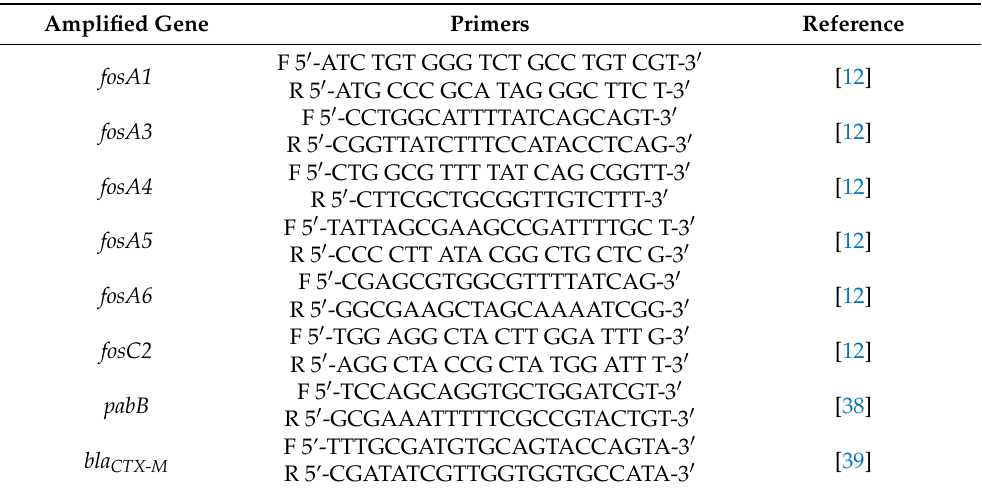
Table 3. Primers and PCR conditions used to determine the presence of fos and bla CTX-M genes and the O25b-ST131